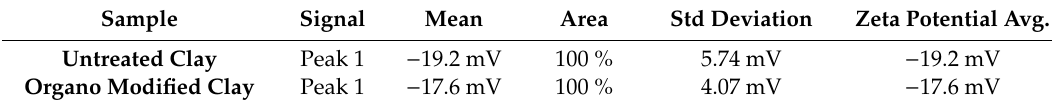
Table 2. Zeta potential of untreated and organo modified MMT clay.